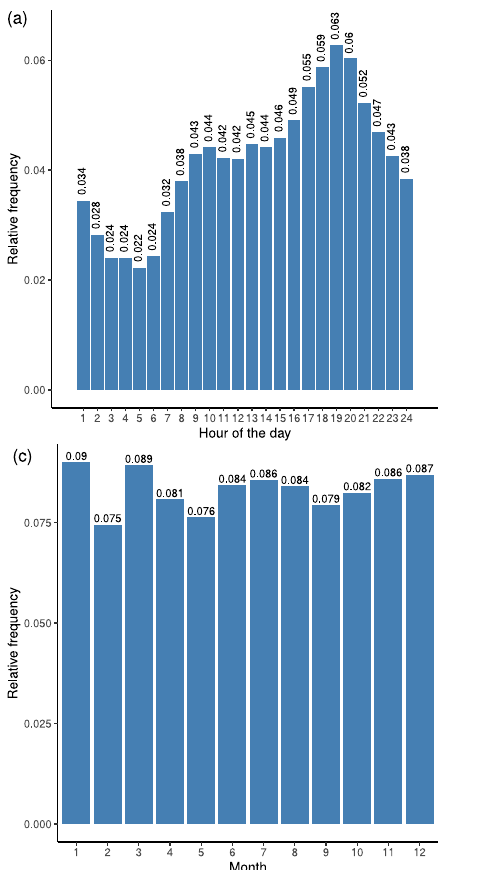
Figure 13. Empirical probabilities of the initial time of emergency ambulance trips evaluated at three different time scales. ( a ) The time scale of hours. ( b ) The time scale of weekdays. ( c ) The time scale of months. The analysis was done on “sps” and “sphs” trips. To avoid the bias caused by different availability of data from ambulances, in panel ( c ), we considered only trips that took place in 2018, as the data from all vehicles were available for that complete year.